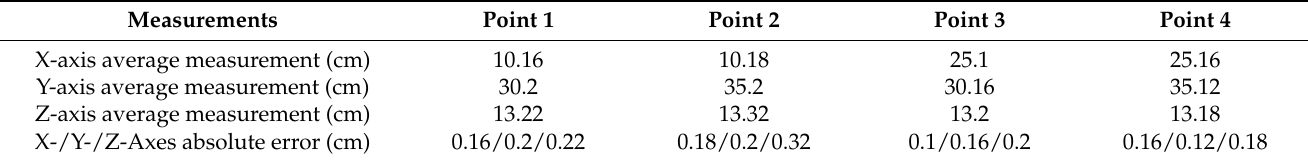
Table 1. Measurement results of seedling center.